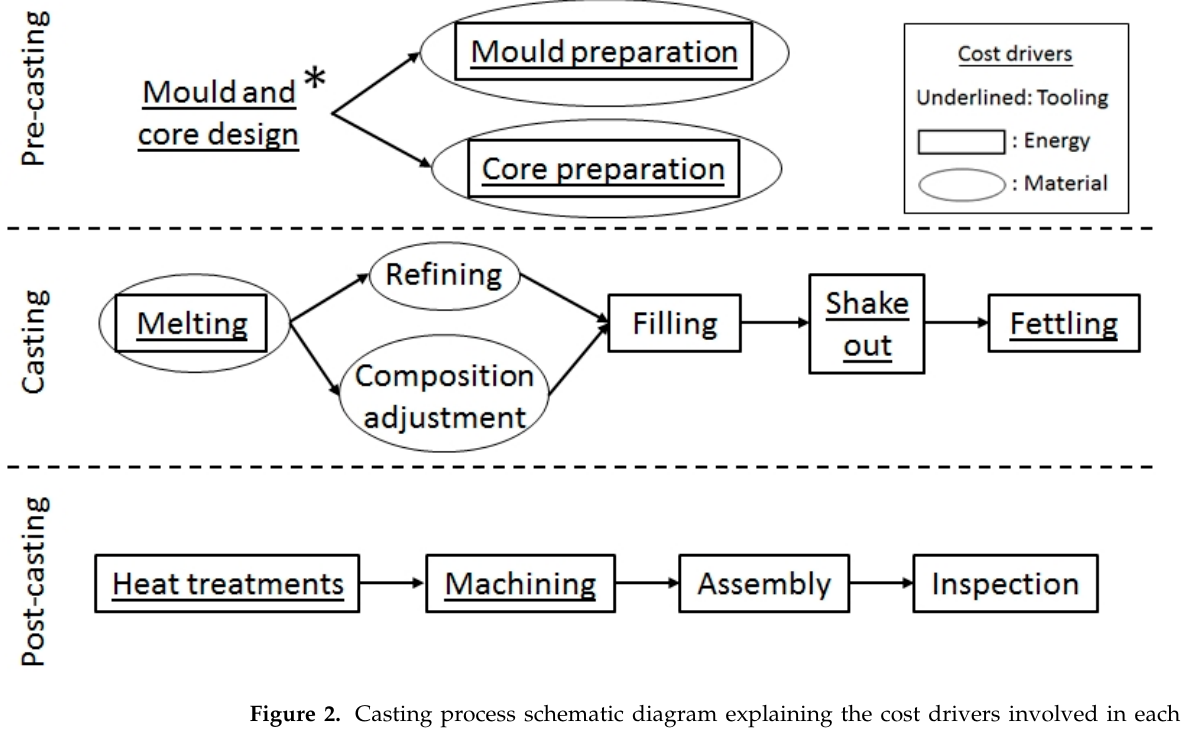
Figure 2. Casting process schematic diagram explaining the cost drivers involved in each step. * Highly qualified labour involved.